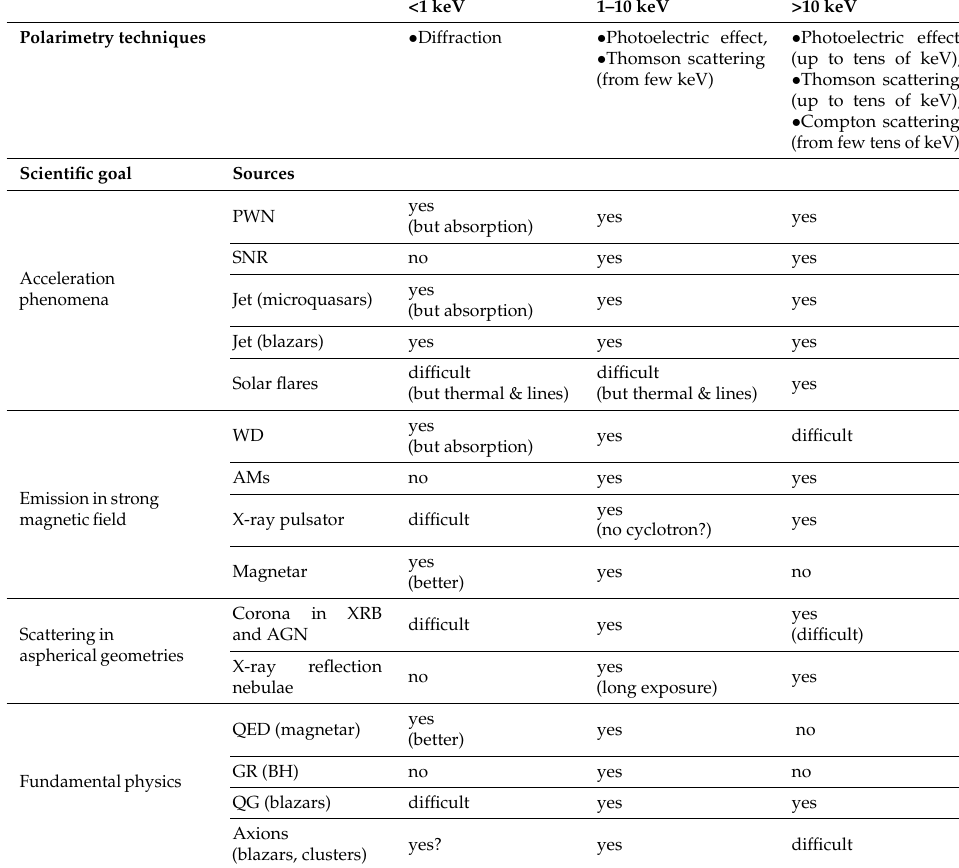
Table 1. Polarimetry techniques and scientific goals for different energy